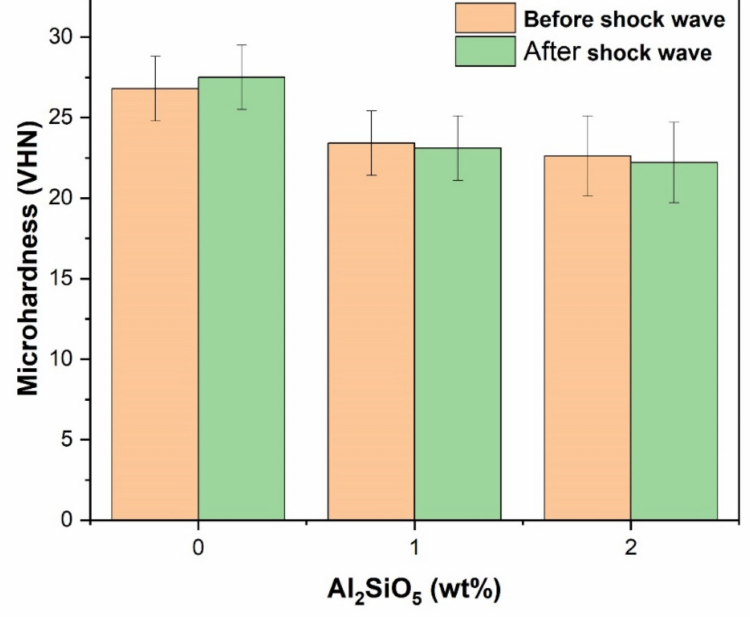
Figure 9. Microhardness of AA5083 and composite samples before and after shock wave